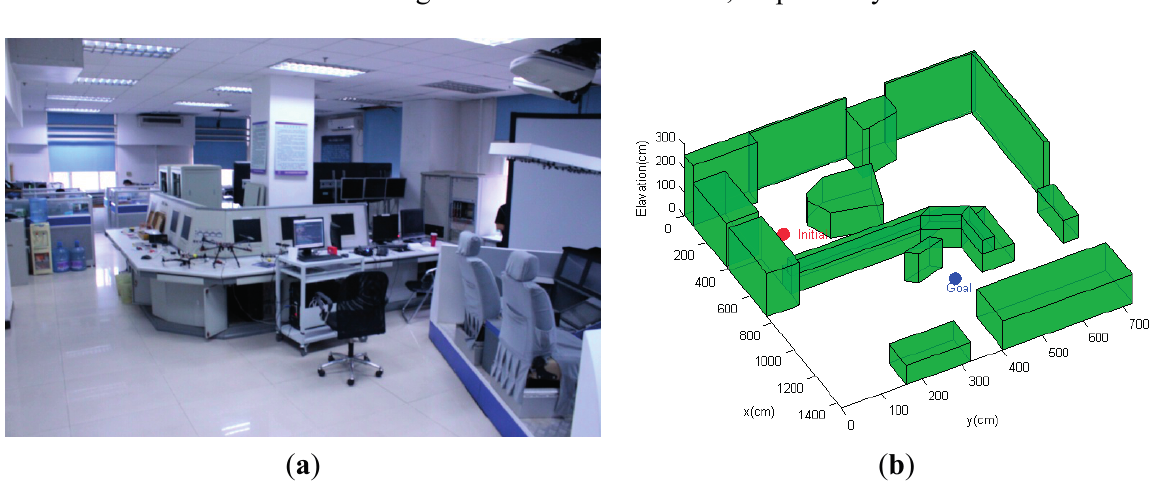
Figure 10. Indoor environment simulation Scenario 2: ( a ) view of a typical cluttered laboratory; ( b ) simulated 3D model of the unstructured, GPS-denied indoor environment. The red and blue dot indicate the initial and goal location of the MAV,